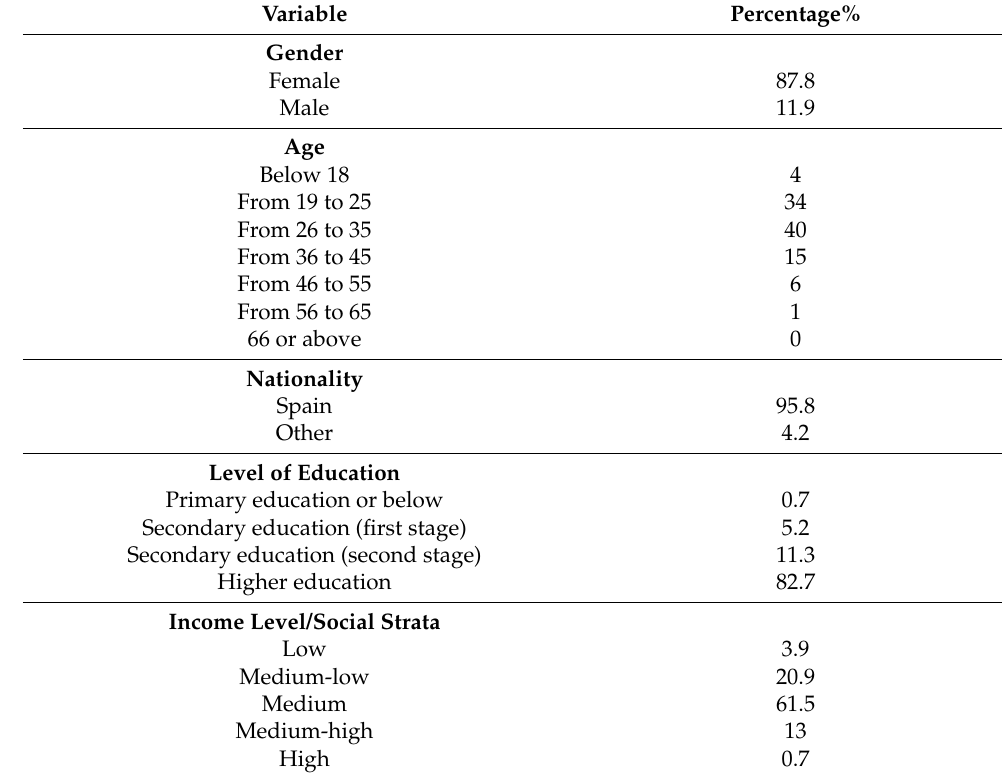
Table 1. Socio-demographic and consumer-related characteristics of the